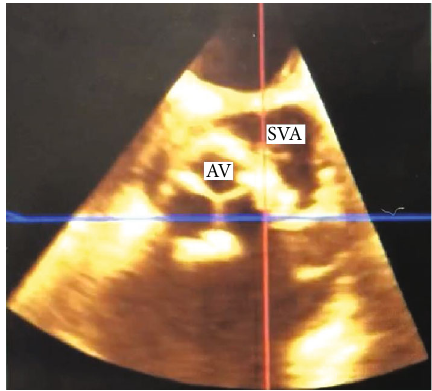
Figure 3: Transesophageal echocardiogram showing aortic sinus of Valsalva aneurysm extending posteriorly to interatrial septum (white arrow) and ventricular septal defect (yellow arrow). View: color Doppler, apical four